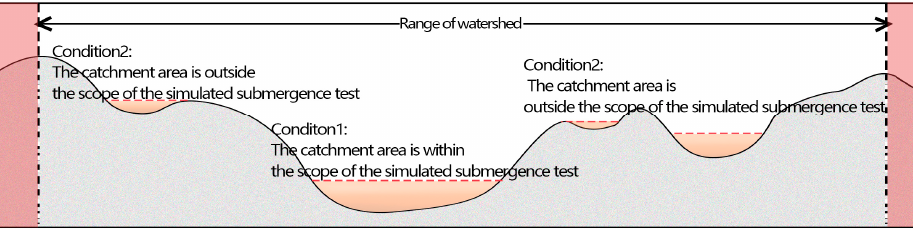
Figure 5. Submerged area location.